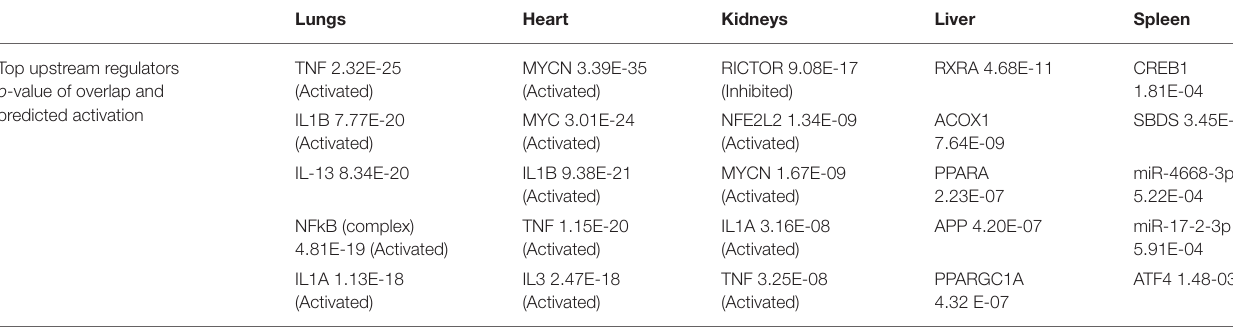
Lungs Heart Kidneys Liver Spleen Top upstream regulators p -value of overlap